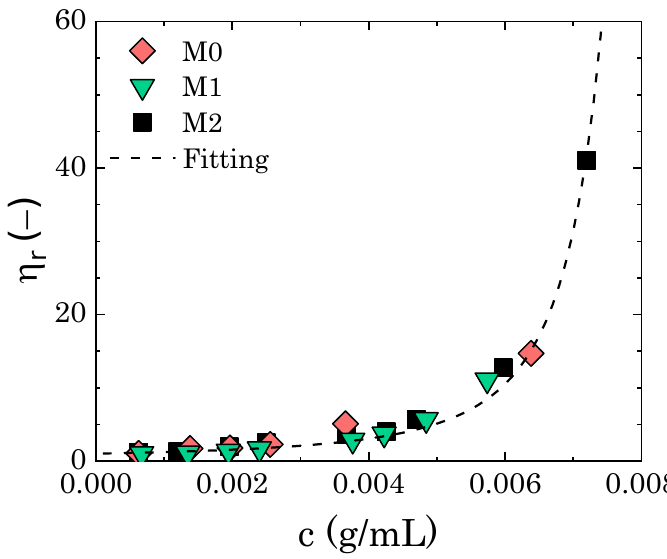
Figure 4. Relative zero-shear viscosity as a function of Carbopol concentration for mannitol contents of 0% (M0), 1.46% wt (M1), and 2.87% wt (M2). The dashed line is the fitting with Mooney’s